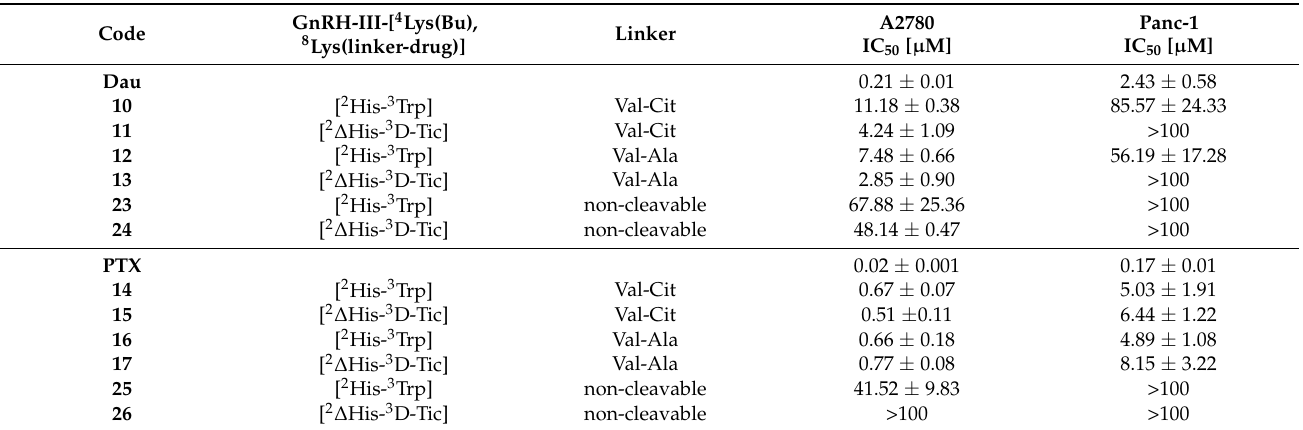
Table 1. In vitro cytostatic effect of cleavable and non-cleavable GnRH-III-Dau and -PTX conjugates on A2780 human ovarian cancer and Panc-1 human pancreatic cancer